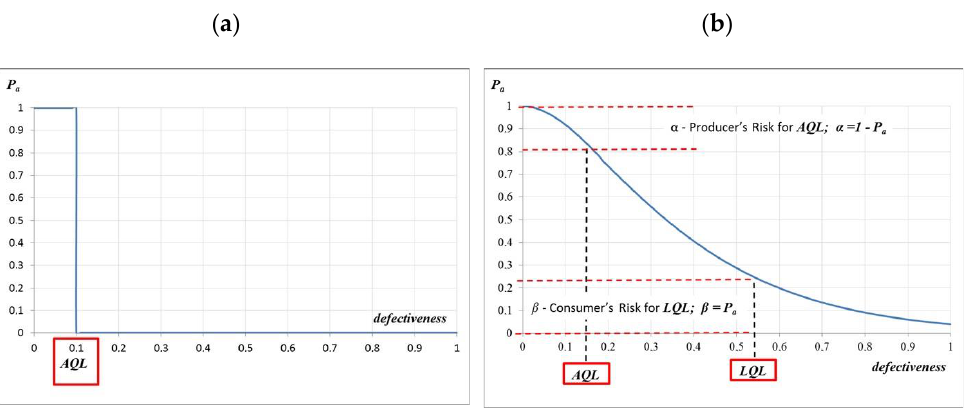
Figure 8. OC curve: ( a ) at 100% control and ( b ) with producer’s and customer’s risks. The better — or more selective — the reception plan is, the closer the OC curve plot is to that shown in Figure 8 (steeper).